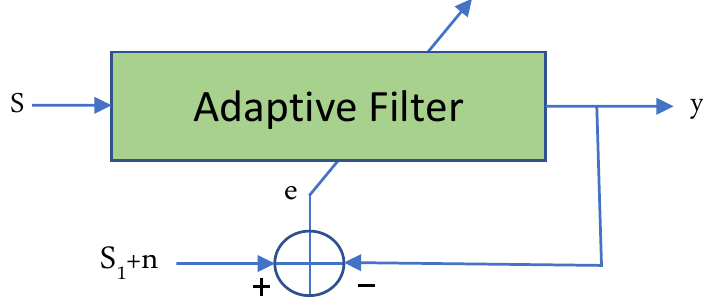
Figure 2. A general diagram of adaptive filter based on